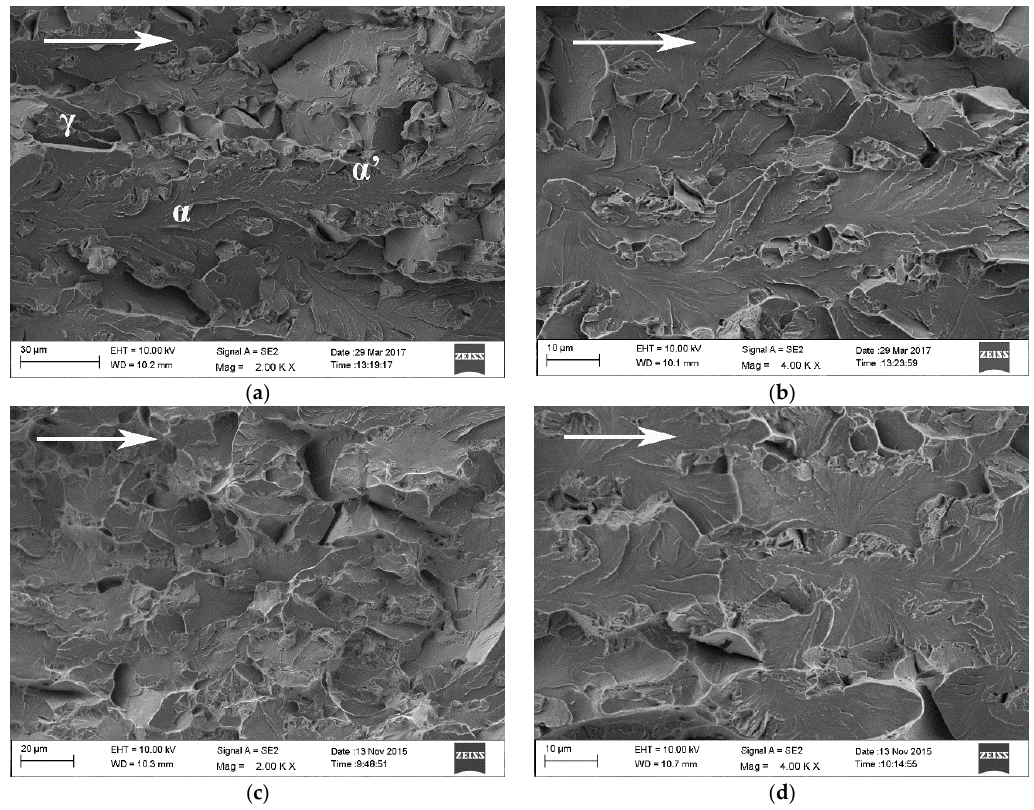
Figure 6. Fracture surfaces of constant load tensile specimens of steel B ( a , b ) and steel C ( c , d ).